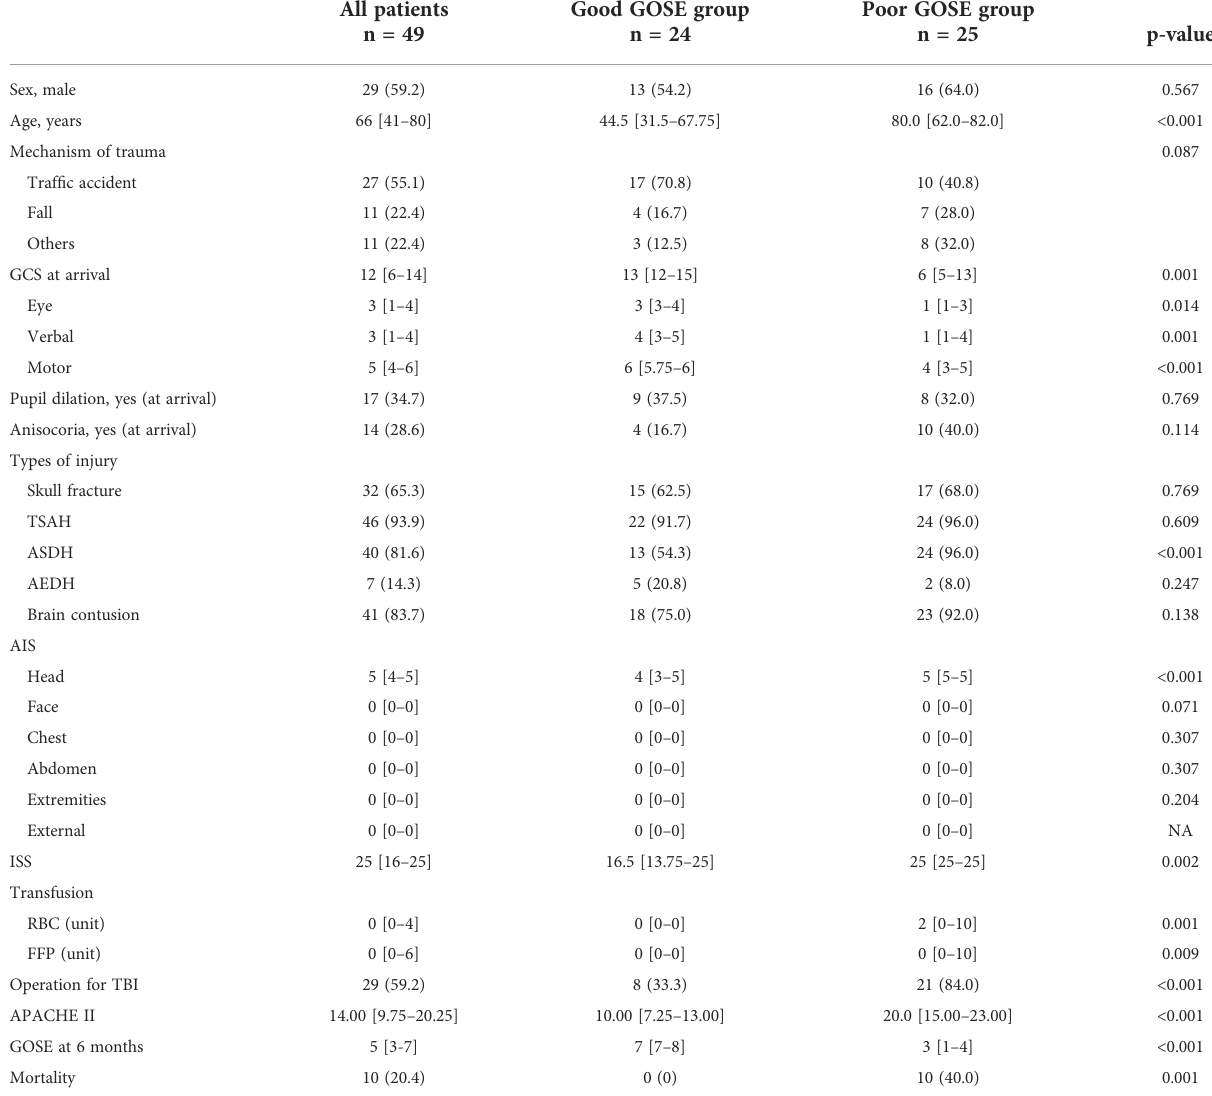
TABLE 1 The baseline characteristics, severity, and outcome of the study population. All